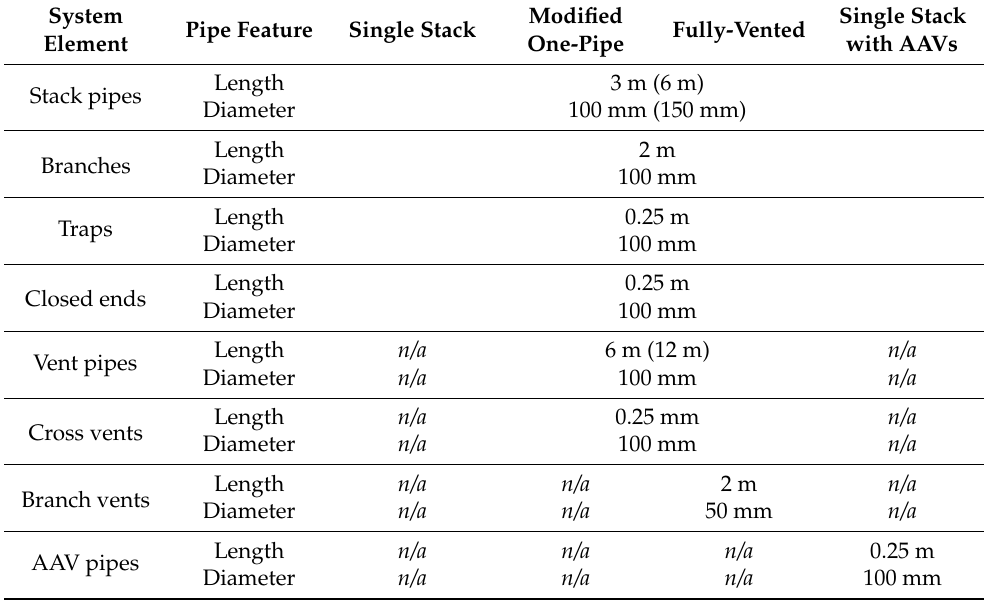
Table 1. Pipe lengths and diameters for each system configuration. Values are provided for the 10 story building. Where different for the 20 story building, these are shown in